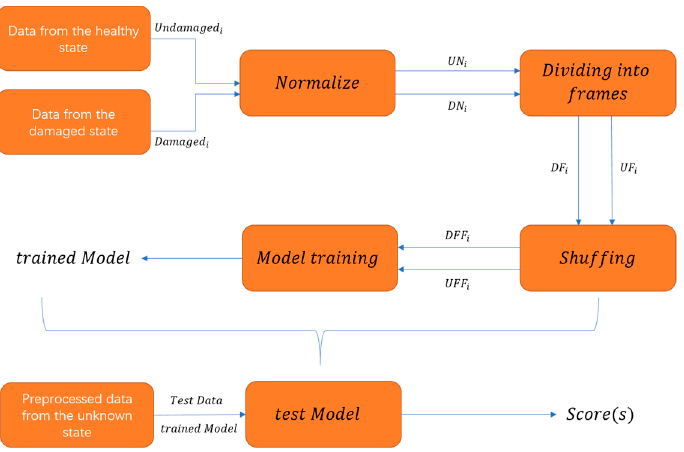
Figure 6. The brief flow of the model from data processing to training model to testing.